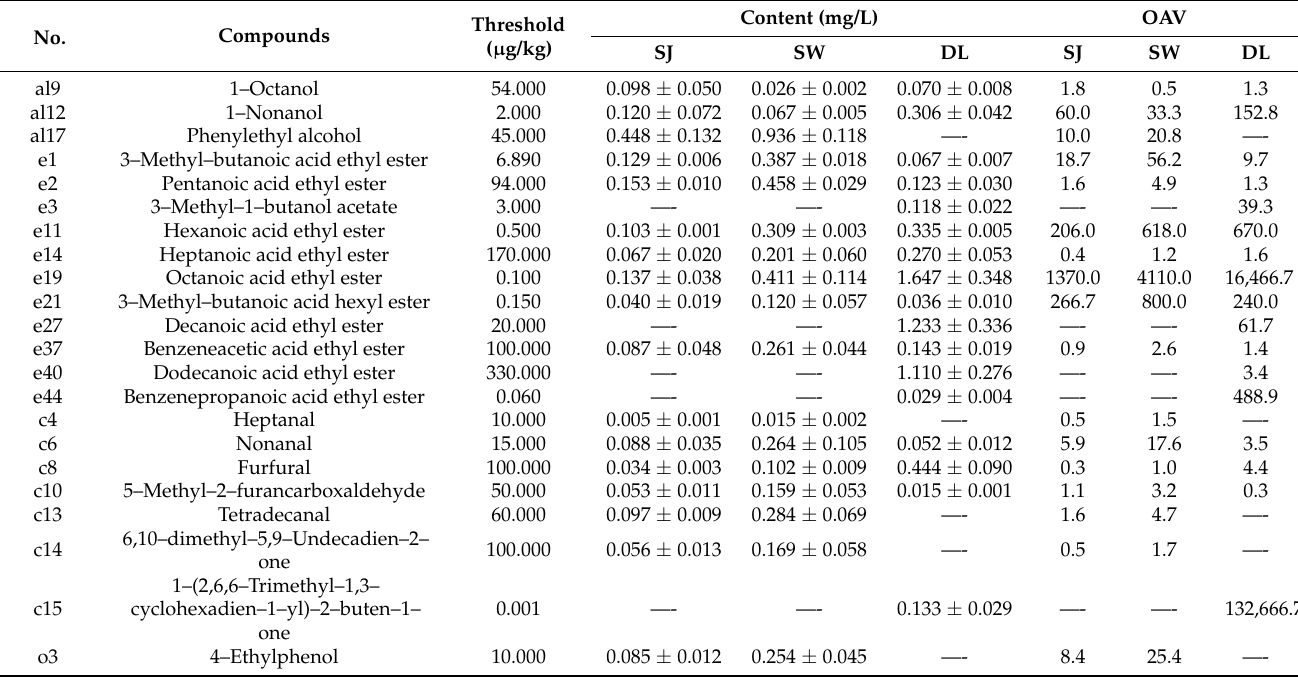
Table 1. OAV of odour–active components in SJ, SW and DL by GC–MS ( n =